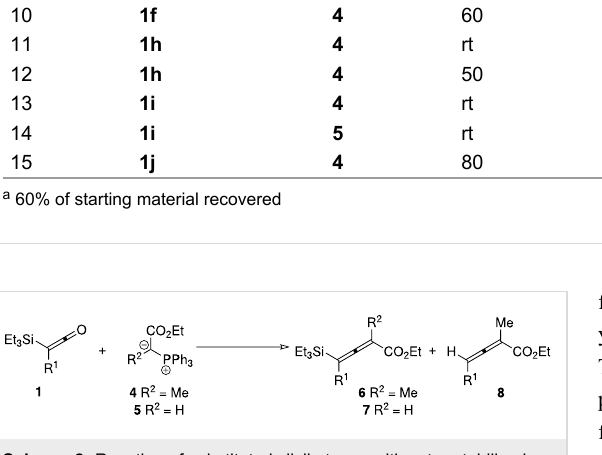
Scheme 2: Reaction of substituted silylketenes with ester-stabilised phosphoranes